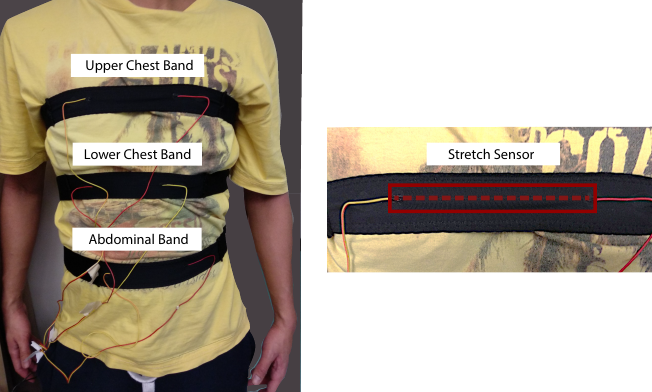
Figure 2. Three custom-made sensor bands to monitor the expansion and contraction of the torso while breathing (and talking). The red dashed line shows the positioning of the